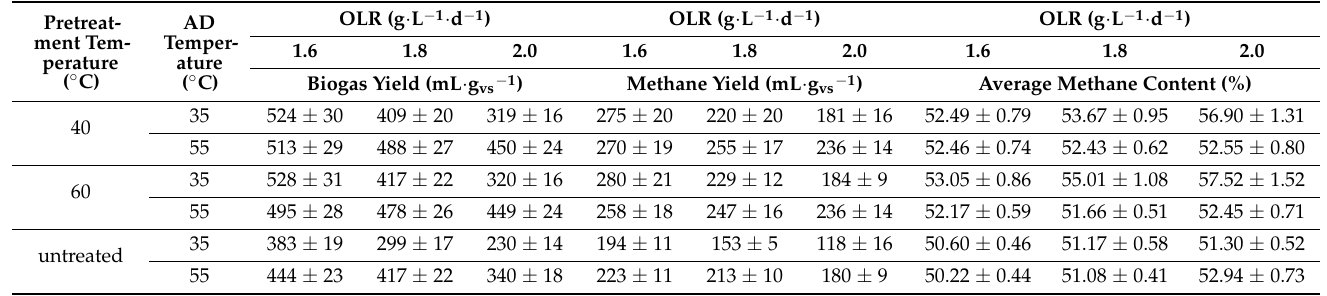
Table 2. Comparisons of different anaerobic digestion performance